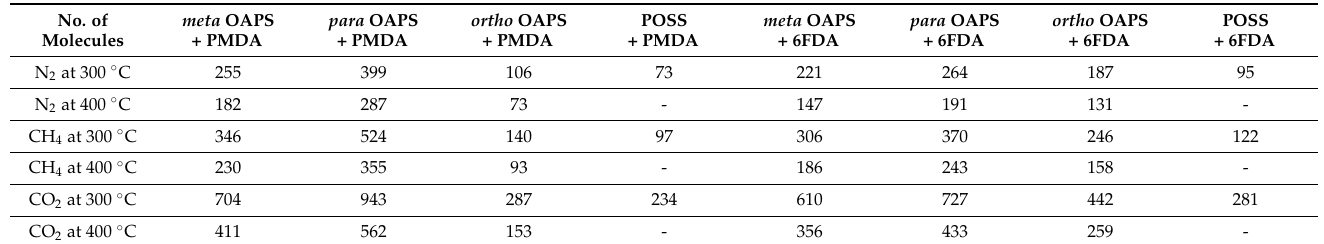
Table 3. Converged numbers of N 2 , CH 4 and CO 2 molecules sorbed by the polyOAPS/POSS-imides networks at both 300 °C and 400 °C and at a single-gas feed pressure of 60 bar. The standard errors on the mean number of penetrants predicted are, in all cases, no more than ±1 molecule (Figure S4, Supporting